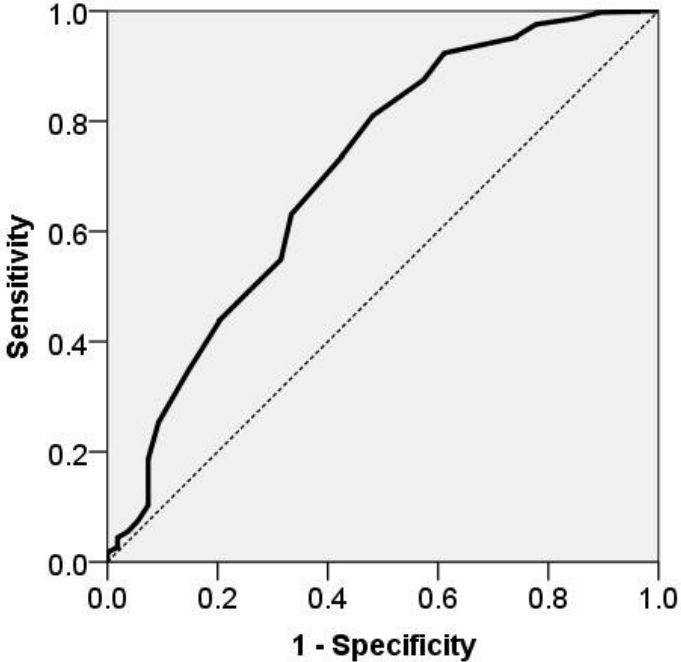
Figure 5. Receiver operator characteristic curve of neck circumference, for the differentiation between OSA and normal controls. The ROC curve illustrates the high OSA discriminatory performance of neck circumference—NC (area under curve AUC = 0.71, with a corresponding 95% confidence interval (CI) of 0.63–0.79, p <